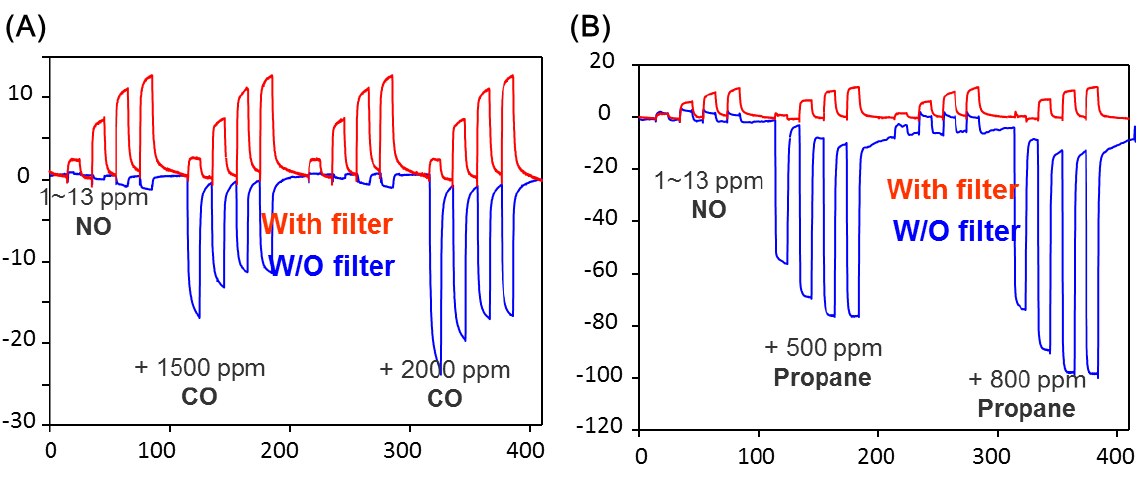
Figure 8. Interference effects for device shown in Figure 7. ( A ) CO with (top) and without filter; ( B ) propane with (top) and without filter (adapted from Reference [36]).